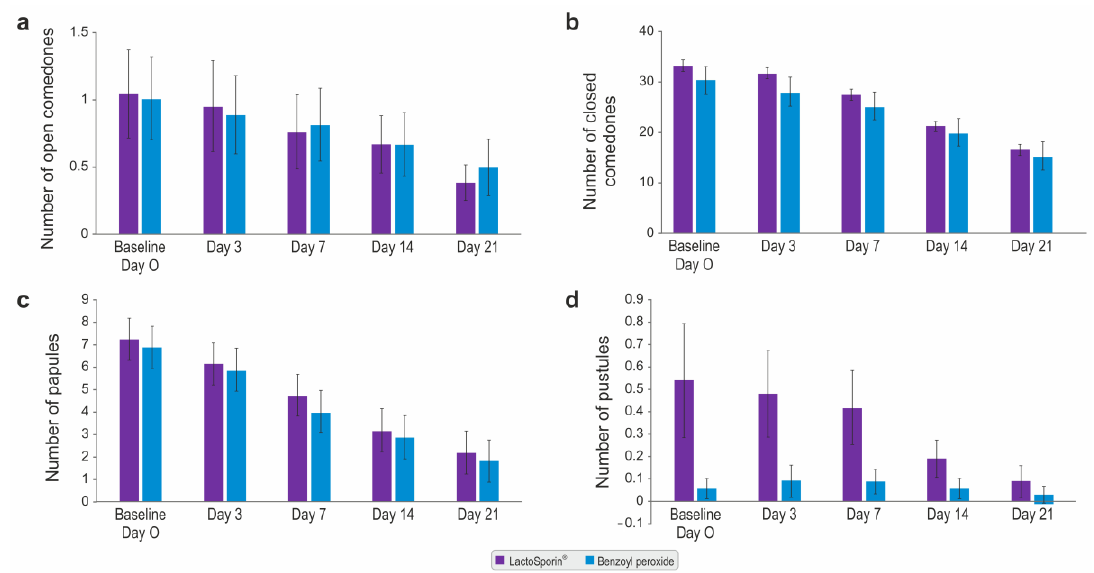
Figure 5. Dermatological Assessment: total number of open comedones, closed comedones, papules and pustules were counted by a dermatologist at day 0, day 3, day 7, day 14 and day 21. ( a ) Count of open comedones. ( b ) Count of closed comedones. ( c ) Count of papules. ( d ) Count of pustules. Values are expressed as mean ±